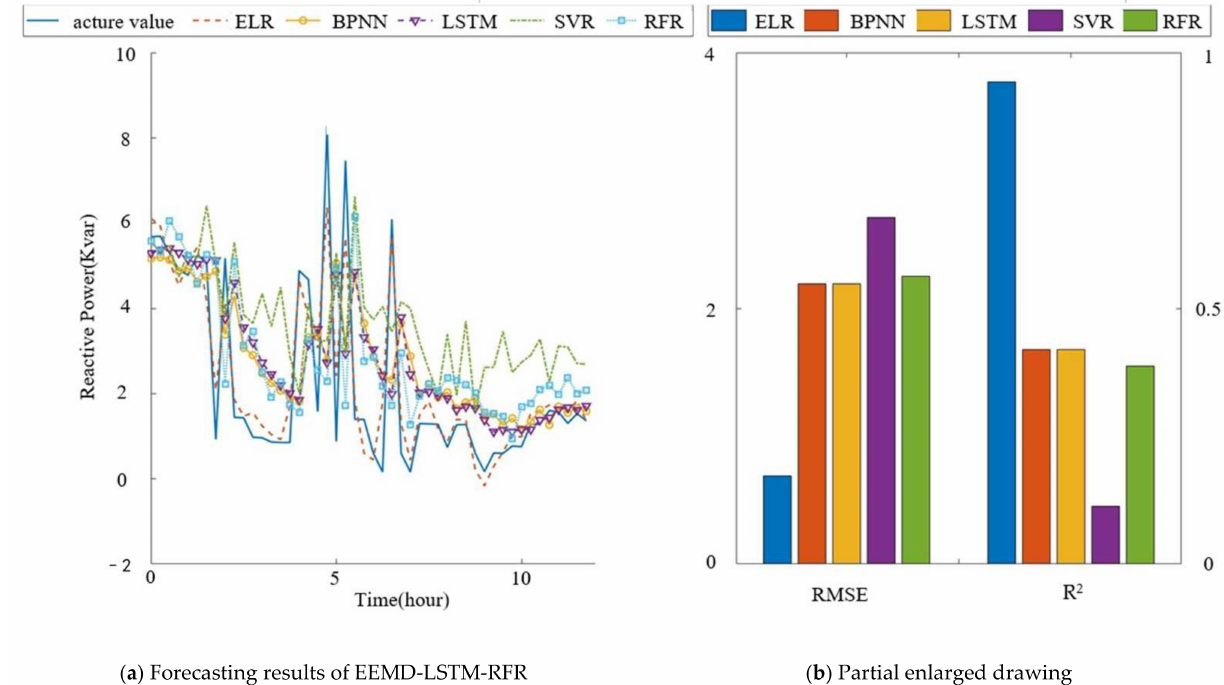
Figure 10. Results of four groups of conventional forecasting algorithms.